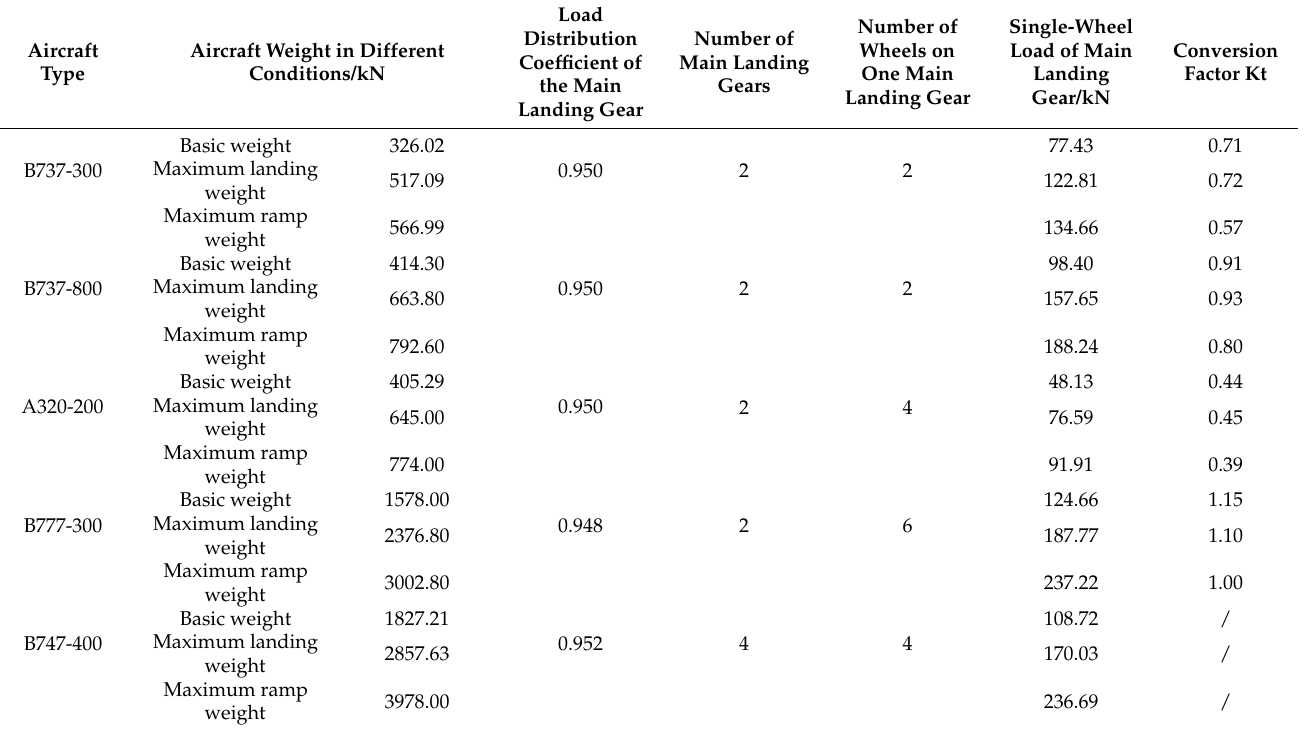
Table 2. The single-wheel load conversion of different aircraft